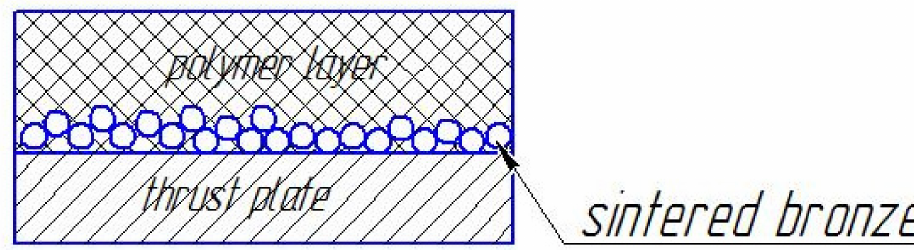
Figure 2. Location of friction with the